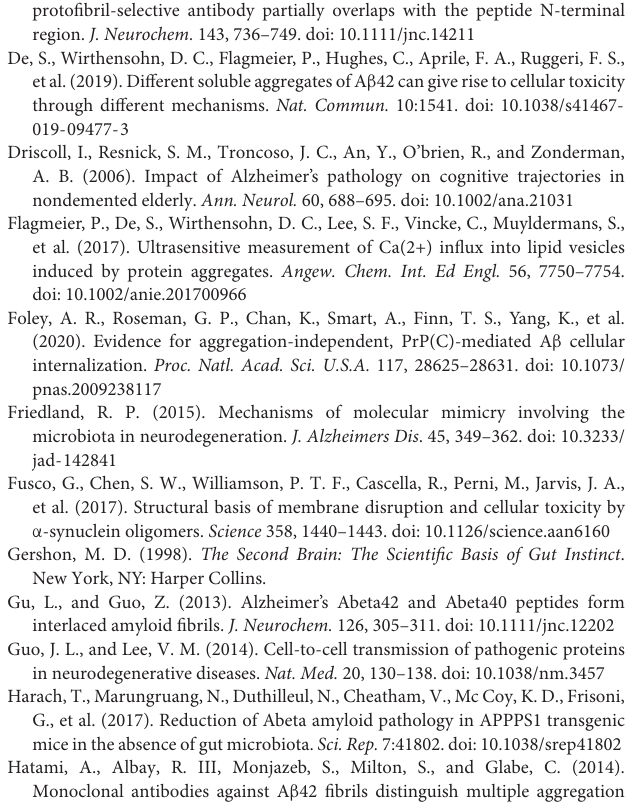
Supplementary Figure 2 | Confocal fluorescence images of whole murine APP/PS1 brain sections using Cy3-labeled anti-A β 42 monoclonal antibody 1F12